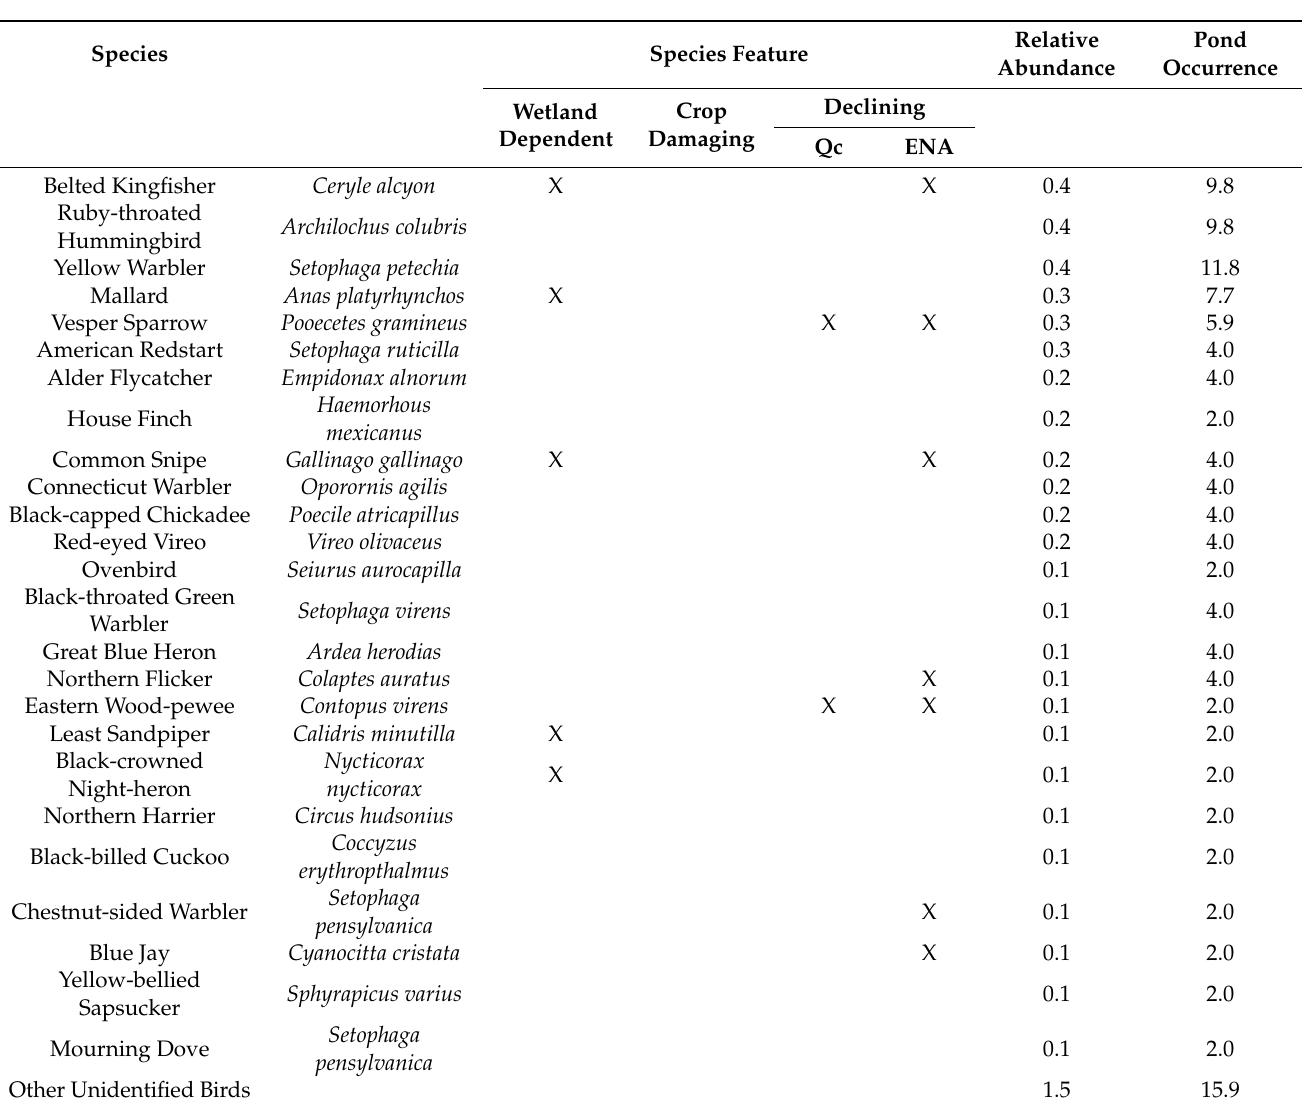
Total bird abundance (all species combined), total abundance of crop damaging species, and total abundance of declining species were positively related to the adjacent (Table 4). The area of cereals and of mixed-wood forest surrounding the pond had a negative influence on the three selected bird abundance indicators. Width of riparian strips also had a positive effect on the abundance of declining species, except with the model obtained for the 500 m radius (Table 4). In contrast, only two habitat variables had an effect on species richness: width of riparian strip had a positive effect, and distance to the closest farm building had a negative effect (Table